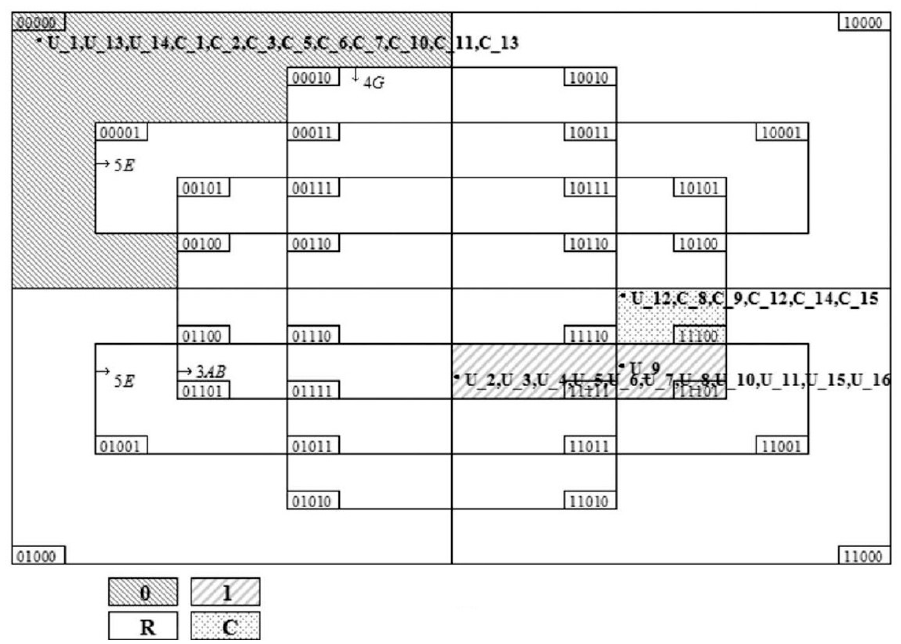
Figure 1. Venn diagram of the QCA results of empirical data in the students (e.g., C_1, C_2, etc.) from the control group compared to the students (U_1, U_2, etc.) from the activity group.